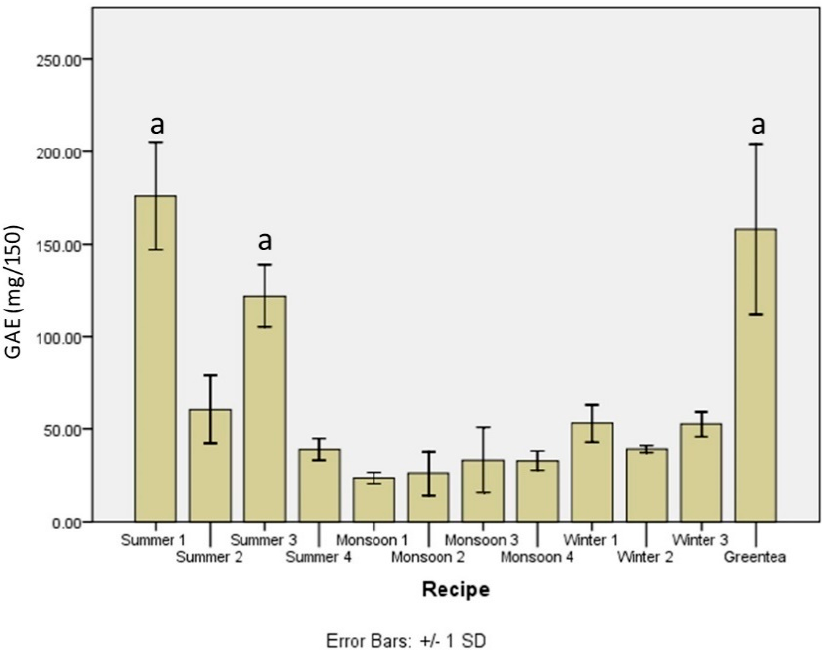
Figure 2. Phenolic content of Thai identity tea recipes as compared to green tea, measured by Folin-Ciocalteu method. Letter a indicates significance ( p < 0 . 05) .